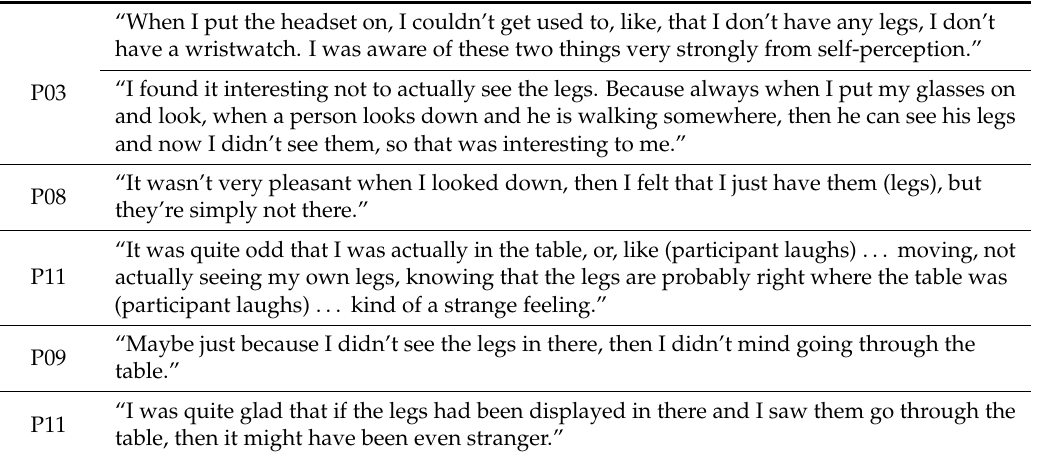
Table 8. Verbatim excerpts of statements by participants: Where are my legs?